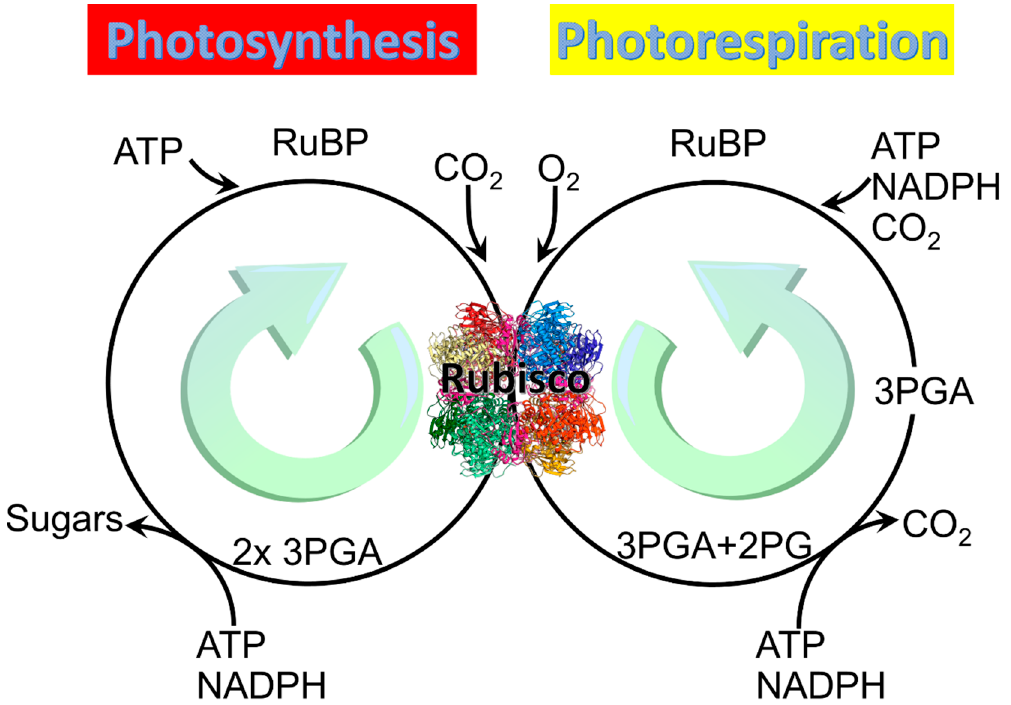
Figure 1. Two main reactions of Rubisco: Photosynthesis and photorespiration. Rubisco structure picture credit: Laguna design / science photo library.